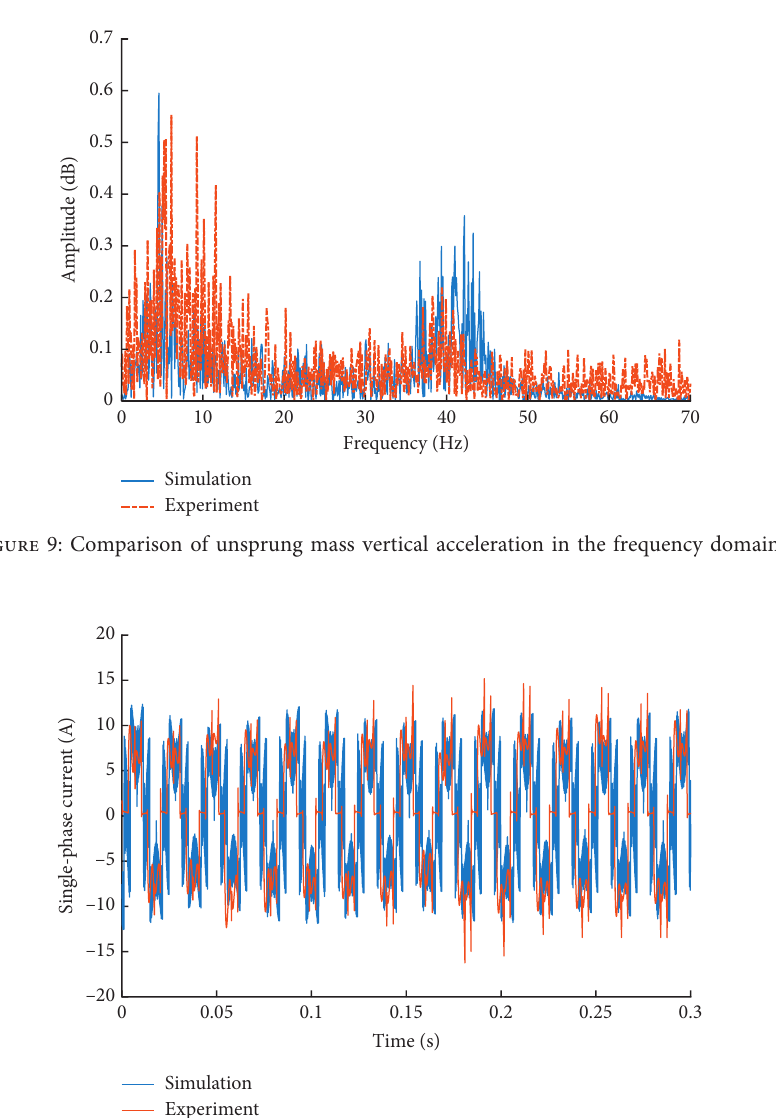
Figure 10: Comparison of single-phase current in the time domain.